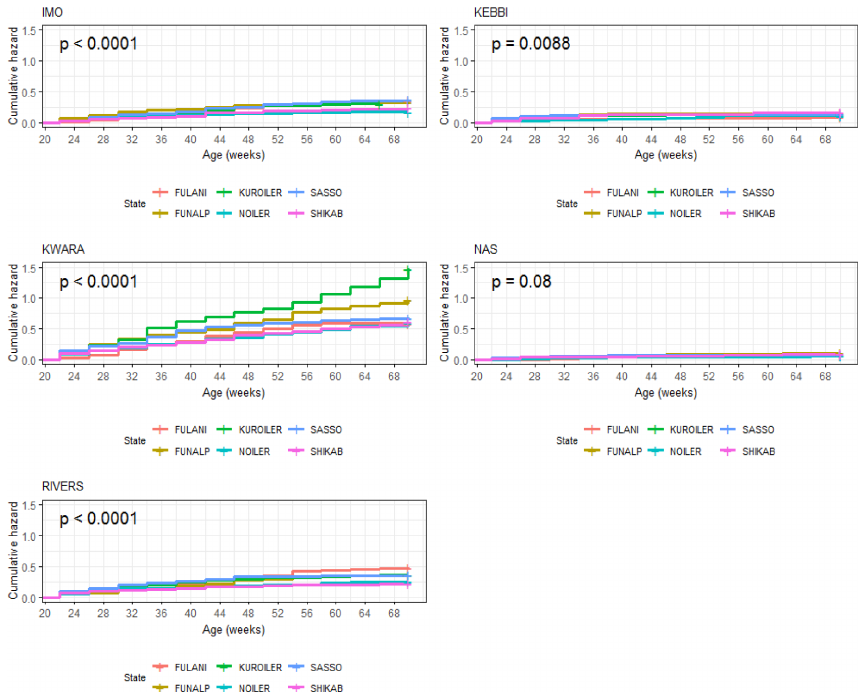
Figure 19. Breed by environment interaction on cumulative hazard of female birds raised on-farm in ACGG Nigeria project zones (22– 70 weeks)